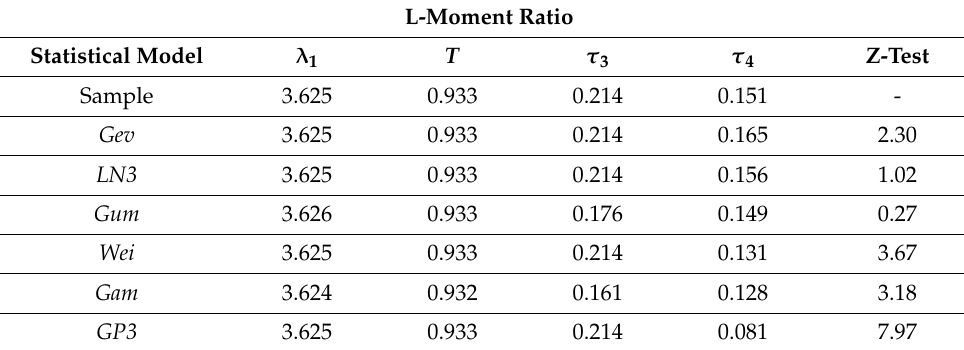
Figure 3. ( a ) Wave height data for Portuguese waters of the North Atlantic-1994-January; ( b ) Wave height data for Portuguese waters of the North Atlantic-1994-February; ( c ) Wave height data for Portuguese waters of the North Atlantic-1989-March. Table 1. Z-test values of sample and